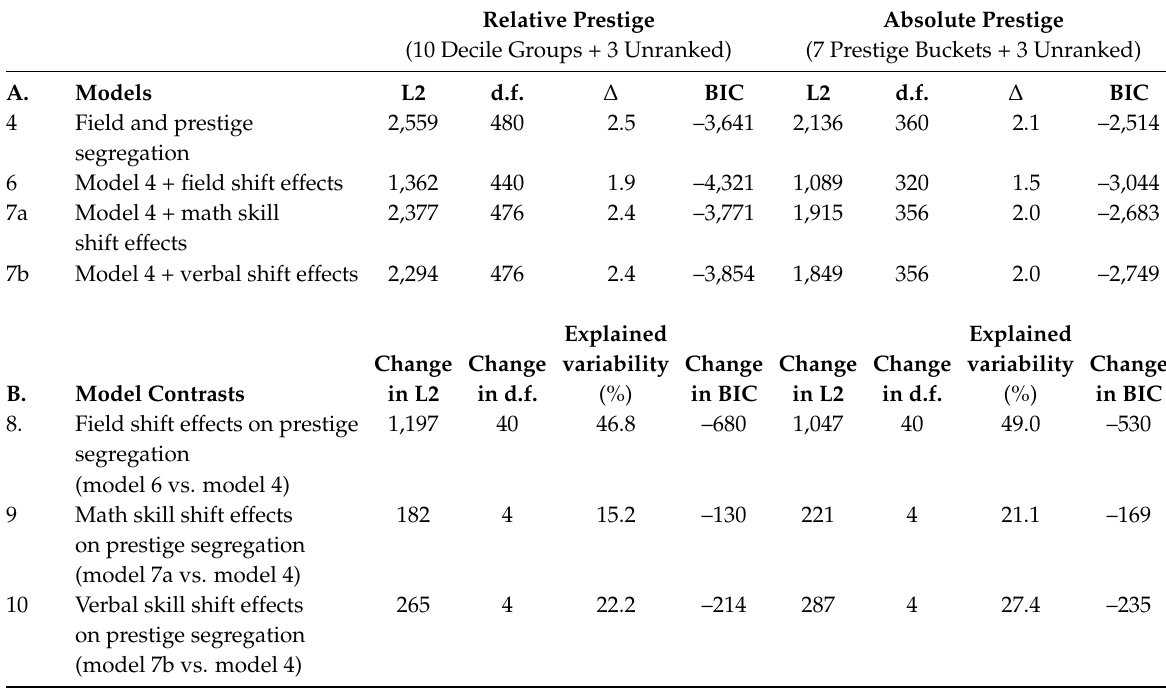
Table 3: Fit statistics for multiplicative shift effect models of prestige